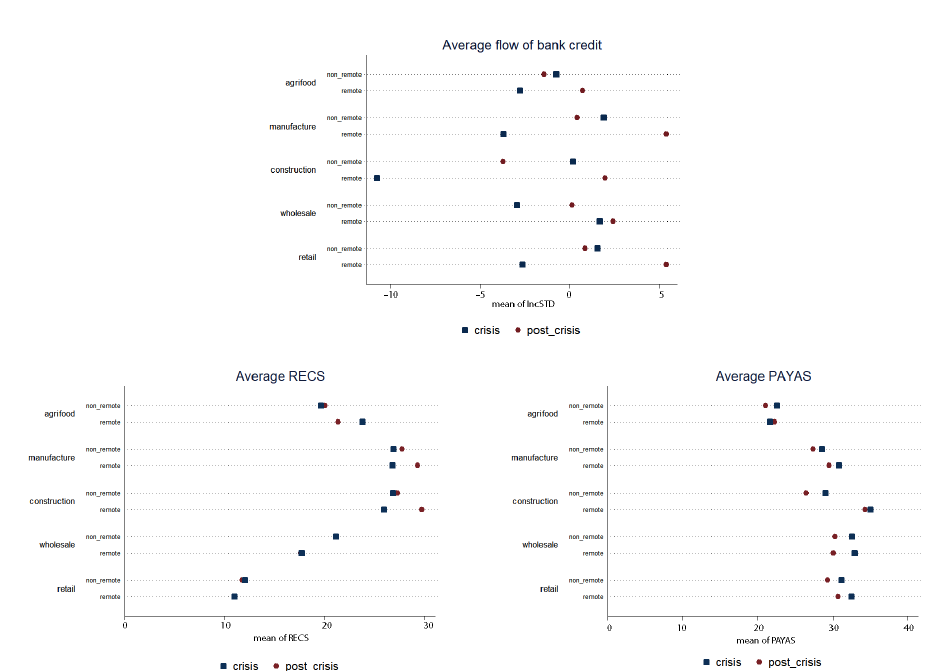
Figure 3. Flow of bank credit and trade credit: mean (in %) during (2009–12) and after the crisis (2013–15)